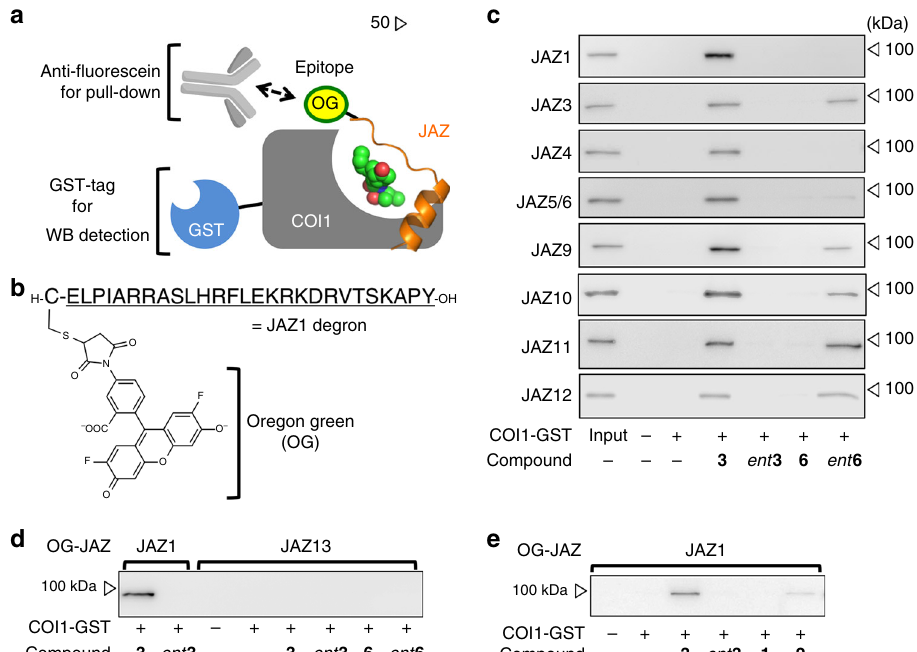
Fig. 2 In vitro COI1-JAZs binding assay with epitope-conjugated JAZ short peptide. a Schematic of in vitro co-immunoprecipitation assay system for agonists of COI1-JAZ co-receptors using epitope-conjugated JAZ degron peptide and GST-COI1. An anti- fl uorescein antibody was used to purify the ternary complex, and a GST-tag was used for the immunoblot assay with an anti-GST antibody. b Molecular design of the Oregon green (OG)-conjugated Jas motif of JAZ1. c Pull-down assay of puri fi ed GST-COI1 (5 nM) with each OG-conjugated JAZ peptide (10 nM) in the presence of stereoisomers of ( + )-COR ( 3 , ent 3 , 6 , or ent 6 , 100 nM). d Pull-down assay of puri fi ed GST-COI1 (5 nM) with OG-conjugated JAZ13 peptide (10 nM) in the presence of 3 , ent 3 , 6, or ent 6 (100 nM). e Pull-down assay of puri fi ed GST-COI1 (5 nM) with OG-conjugated JAZ1 peptide (10 nM) in the presence of 3 , ent 3 , 1 or 2 (100 nM); Goat HRP-conjugated anti-GST antibody was used to detect GST-COI1 in c –